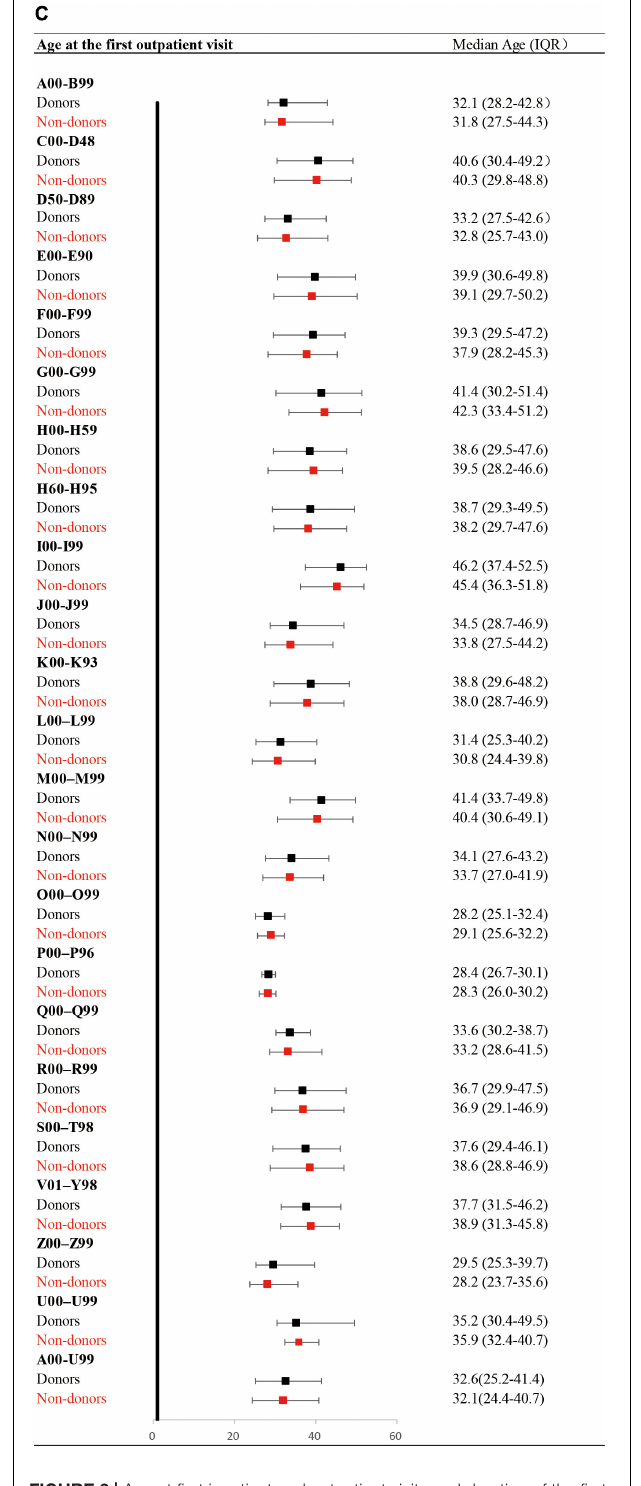
FIGURE 3 | Age at first inpatient and outpatient visits and duration of the first hospitalization based on ICD-10 Chapters ∗ , stratified by blood donors and non-blood donors. (A) Age at the first hospital admission. ∗ ICD Chapters are explained in Supplementary Table 1 . (B) Duration of the first hospitalization. (C) Age at the first outpatient